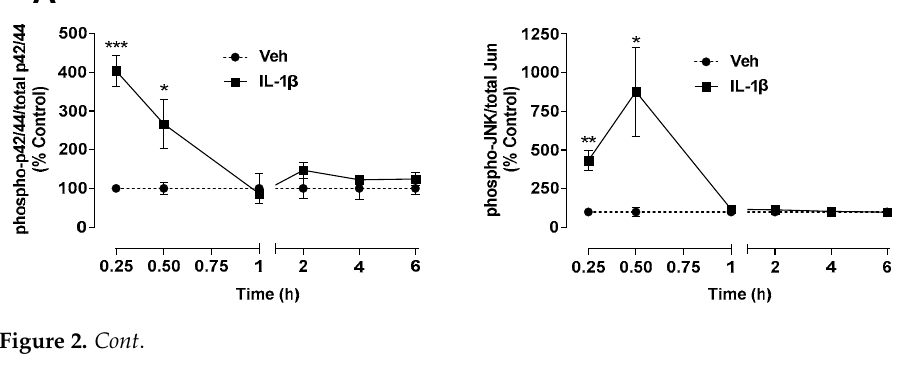
Figure 2. IL-1 receptor-dependent activation of p42/44 MAPK, JNK and p38 MAPK. Time course of IL-1 β -induced activation of p42/44 MAPK, JNK and p38 MAPK ( A ). Effect of IL-1Ra (10 µg/mL) on IL-1 β -induced or basal p42/44 MAPK, JNK and p38 MAPK activation ( B ). The cells were incubated in the presence or absence of IL-1 β (10 ng/mL) for the specified time periods ( A ) or preincubated with IL-1Ra for 2 h and then coincubated with IL-1 β or vehicle for 30 min ( B ). All percentage values shown refer to the respective vehicle control, which was set to 100%. The values shown in the histograms are based on densitometric analyses of blots, whereby the phosphorylated forms were normalized to the respective total form. In the labelling of the MAPK blots ( A , B ), the prefix "p-" stands for "phospho-". The blots shown are representative. In ( A ), the same β -actin blots are shown for the 1-, 2-, 4- and 6-h values of the p42/44 and p38 MAPK analyses, because the analyses of the same lanes were shown here as representative blots. The data are mean values ± SEM of n = 4 ( A , B , upper right), n = 7–8 ( B , upper left) or n = 3 ( B , lower right) experiments per group. * p ≤ 0.05, ** p ≤ 0.01, *** p ≤ 0.001 vs. vehicle control; # p ≤ 0.05, ### p ≤ 0.001 vs. IL-1 β ; Student’s t test ( A ) or one-way ANOVA with Bonferroni’s post hoc test ( B ).